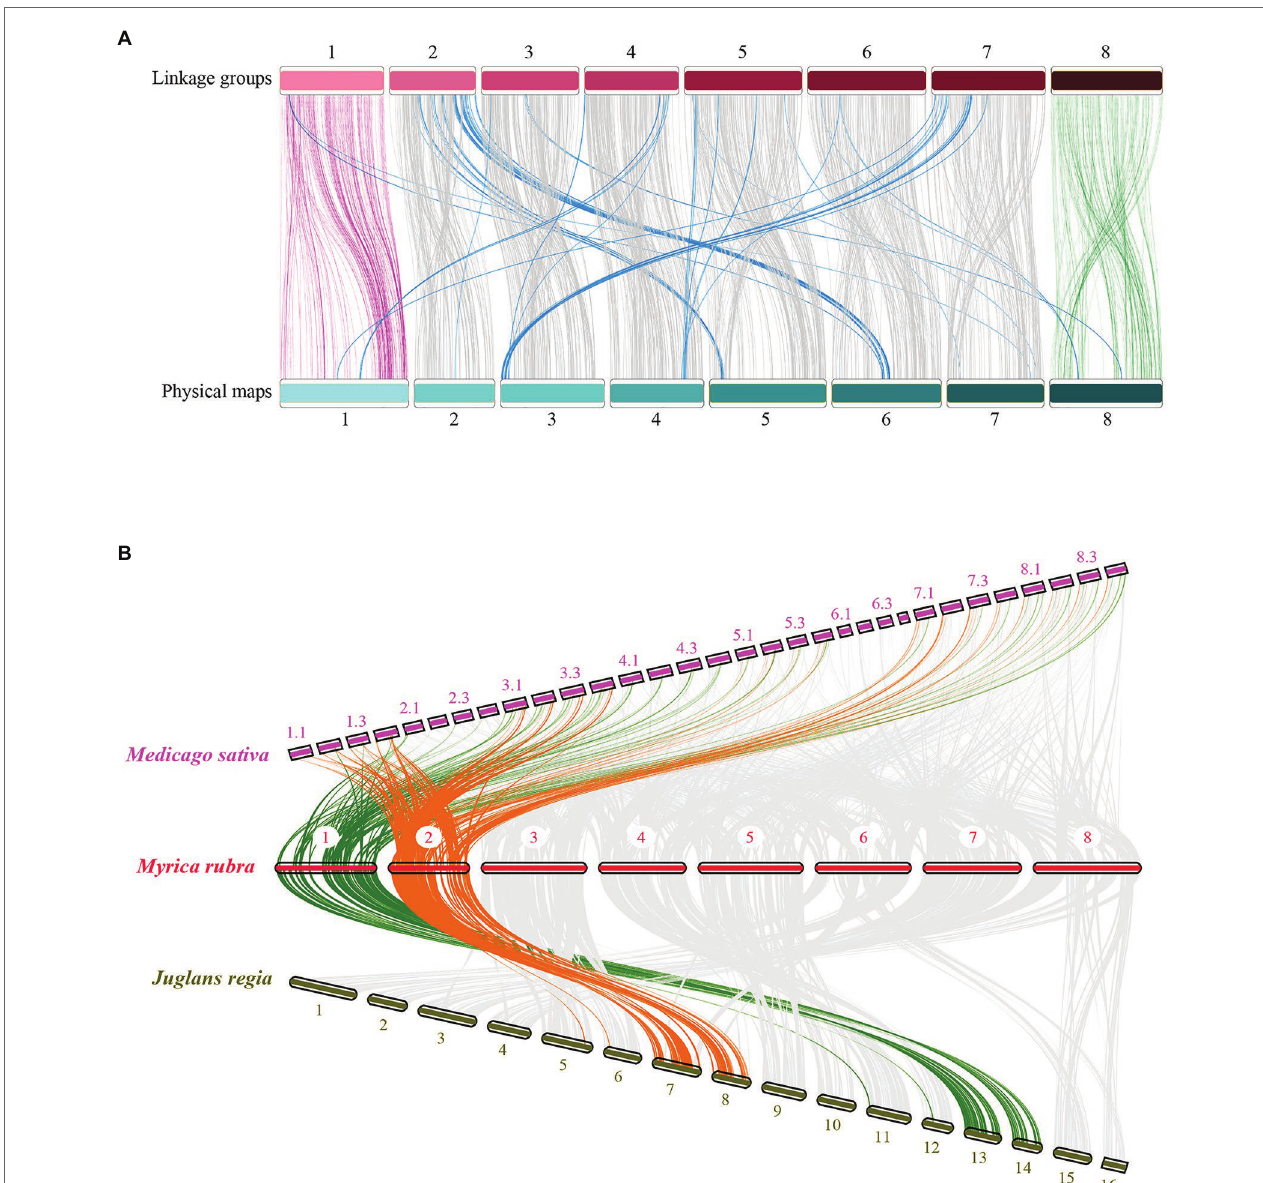
FIGURE 3 | Comparative analysis of the Myrica rubra genome. (A) The collinearity of chromosomes between the genetic map and the physical map, 1–8 represent the eight chromosomes. (B) Syntenies among M. rubra (pseudochromosomes 1–8), Jugians regia (chromosomes 1–15), and Medicago sativa (chromosomes 1–8). In M. sativa , each chromosome was divided into four parts (e.g., 1.1, 1.2, 1.3, and